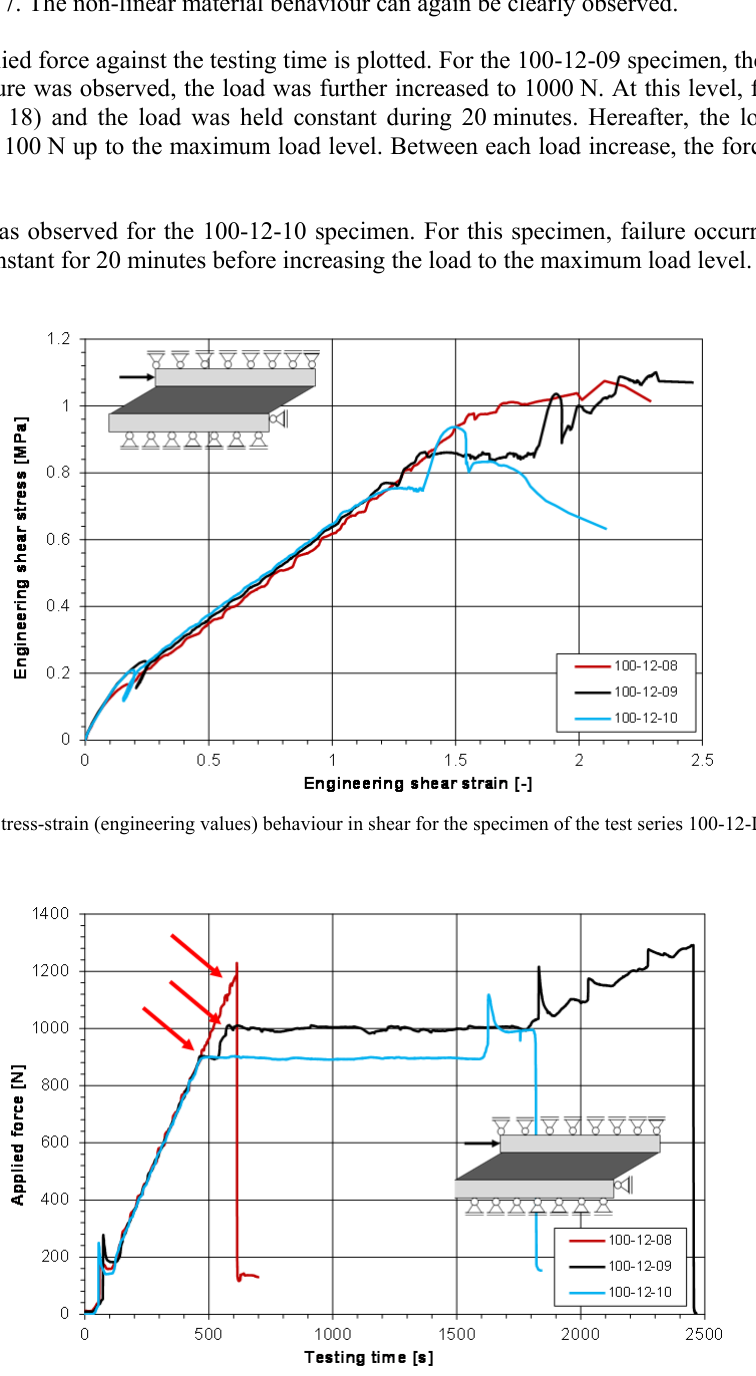
Fig. 18 Applied force plotted against testing time for the series 100-12-LOAD. The arrows are indicting the failure point of the